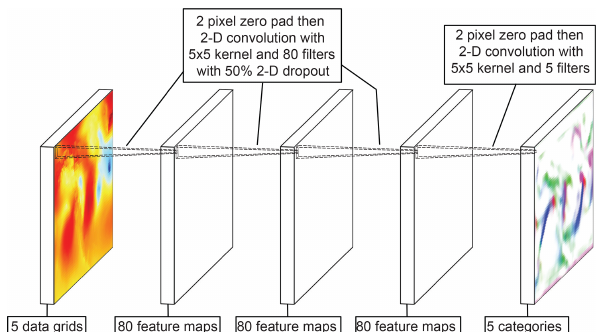
Figure 1. Schematic of the DL-FRONT 2-D CNN architecture. The five category input data grid on the left contains the five input sur- face meteorological 2-D fields (temperature, humidity, pressure, u - component of wind, v -component of wind). The five-category out- put data grid on the right contains five 2-D likelihood estimates for the five front categories (cold, warm, stationary, occluded, and